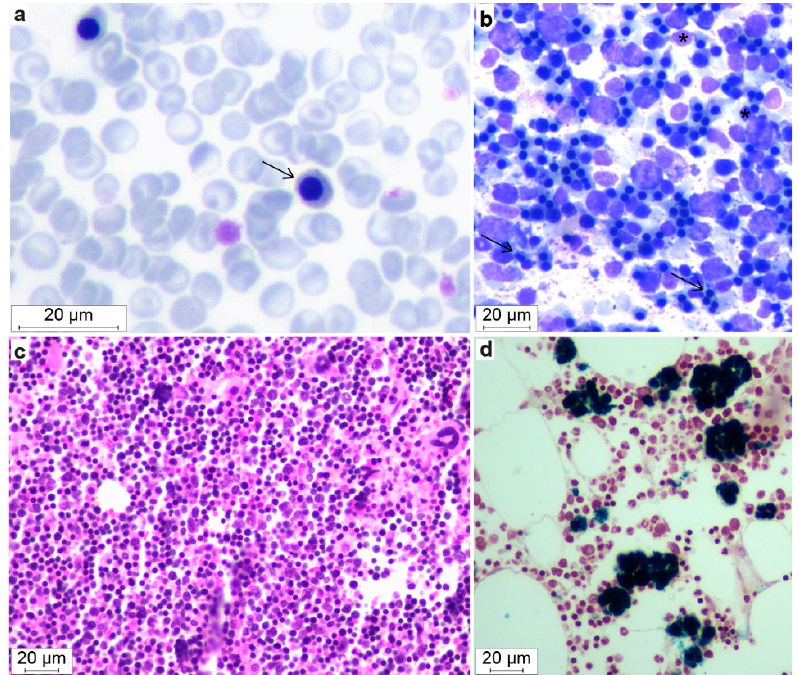
Figure 3. Box plots of hematological parameters and serum bilirubin concentration from affected, related, and unrelated English springer spaniels. ( a ) Hemoglobin concentration (Hb/g/L); ( b ) mean corpuscular volume (MCV/fL); ( c ) mean cell hemoglobin (MCH/pg; ( d ) bilirubin concentration (µmol/L). The median values are indicated by horizontal lines in the boxes, where the first to third quartiles define the boundaries. Whiskers extend to the minimum and maximum values. The af- fected dogs had significantly lower MCV and MCH values than those of both other groups, and they had lower Hb than that of related healthy dogs.